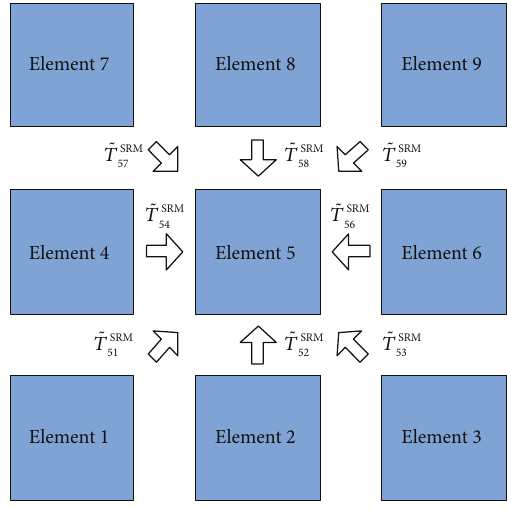
Figure 7: Eight kinds of near-interaction mechanism between nine elements.